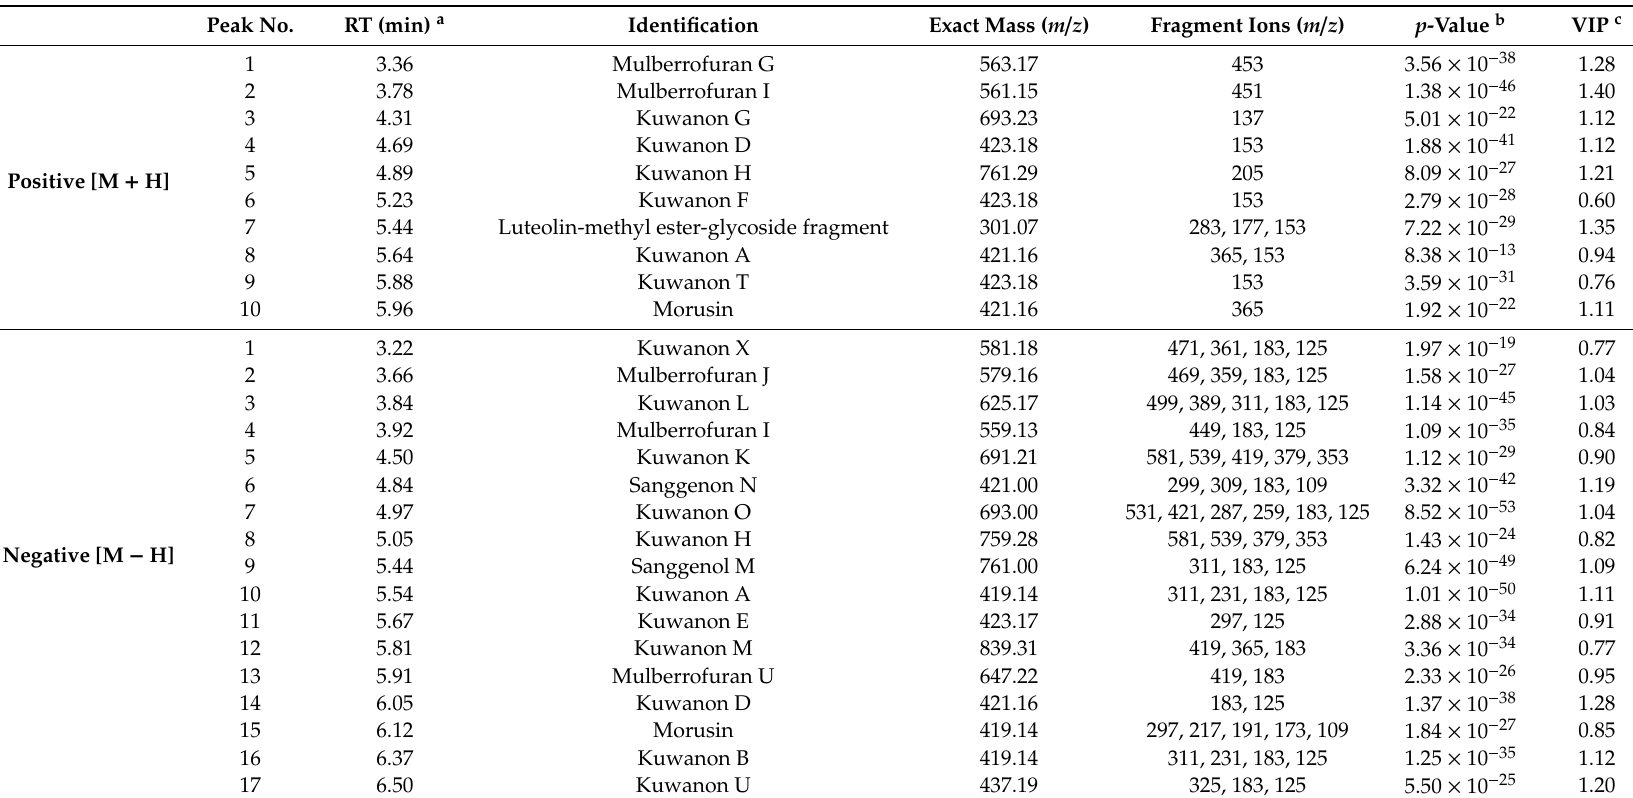
Table 1. Identification of metabolites contributing to the separation among groups on the PLS-DA scores plots of the dataset analyzed by ESI-positive and ESI-negative modes in UPLC–QTOF